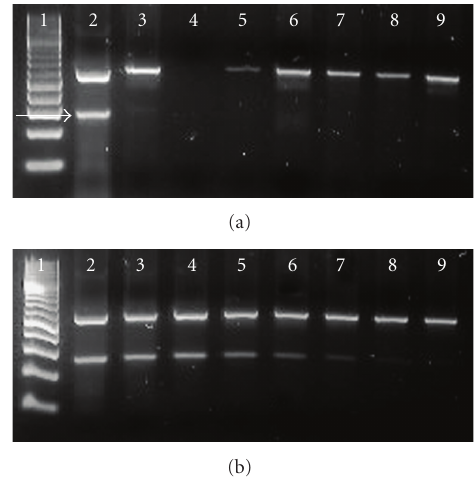
Figure 1: Allele-specific PCR for the detection of the BRAF V600E mutation (2.5% agarose gel). (a) The 273 bp fragment of both mutant and wildtype alleles is always amplified and serves as amplification control. The smaller PCR product (143 bp; arrow) is amplified only in the presence of the V600E (GTG > GAG) mutation. Lane 1: Molecular Weight marker; lane 2: heterozygous mutant DNA control (HT 29); lane 3: homozygous wildtype DNA control; lane 4: no template PCR control (water). Lanes 5–9: analysis of tumor samples. The SGC samples in lanes 5–9 have the BRAF V600E wildtype sequence. (b) Serial dilution of HT 29 DNA in normal wildtype DNA. The allele-specific PCR is able to detect the 143 bp mutation specific fragment in an 15-fold excess of normal DNA. Lane 1: Molecular Weight marker; lane 2: heterozygous mutant DNA control [HT 29] undiluted; lanes 3–9: serial dilutions HT 29/WT DNA (starting from 1:2 up